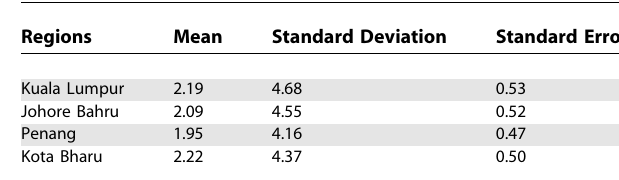
Table 3. Mean Prices (RM) and Variances of the 77